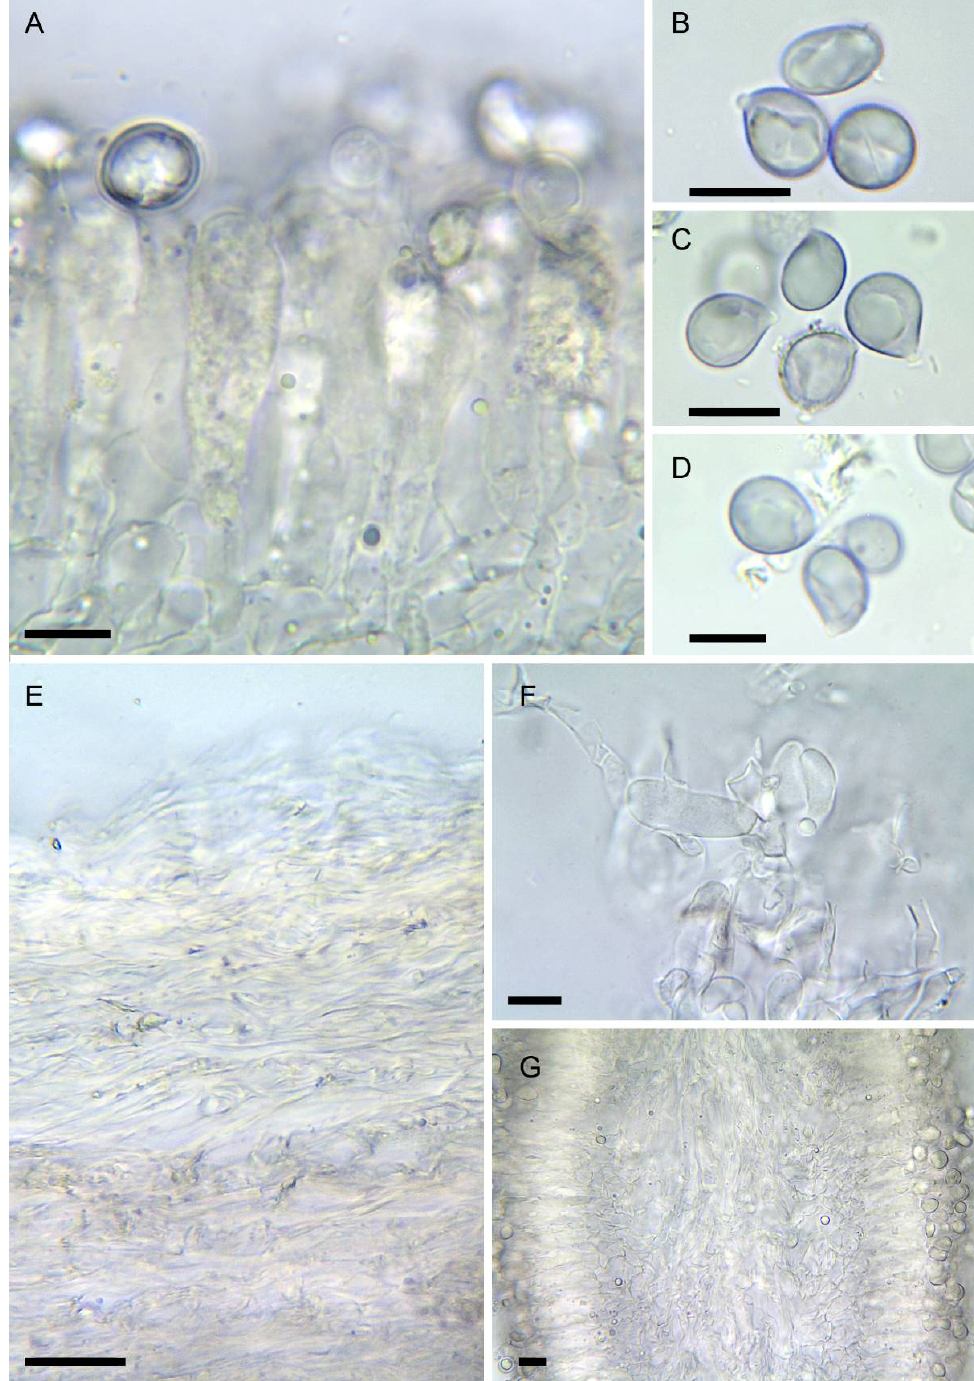
Figure 6. Amanita verna (LIP:0402244, except B : LIP:0402249. ( A ) Hymenium and subhymenium. ( B – D ) Basidiospores. ( E ) Pileipellis, radial section. ( F ) Elements of partial veil (upper surface). ( G ) Hy- menophore, longitudinal section. Observations in 5% KOH solution except A, B: Melzer. Bar = 10 μm. Spores [3/60] usually mostly broadly ellipsoid (50%) and partly subglobose and el- lipsoid (20–30% each), some lacrymoid or pyriform in side view, (7.4–) 8.0–11.1 (–11.3) ×